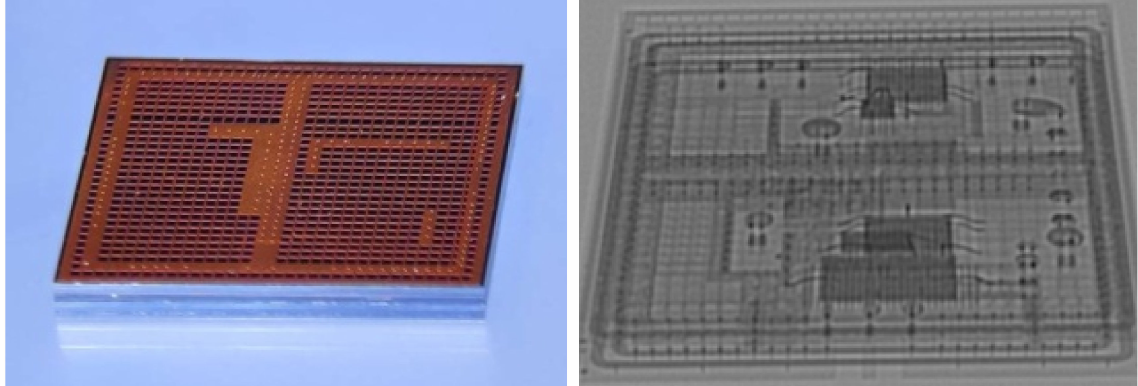
Figure 19. The photo and the X-ray image of the 4-layer stacked RF front-end